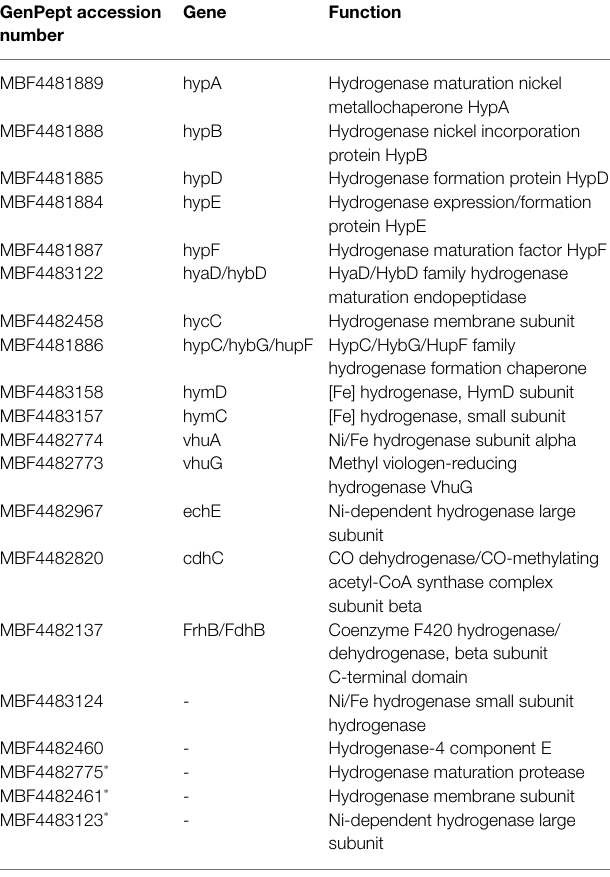
TABLE 4 | Genes involved in the anaerobic cobalamin synthesis pathway in the genome of D. mccartyi from TCE/Cr(VI) biocathode. GenPept accession number